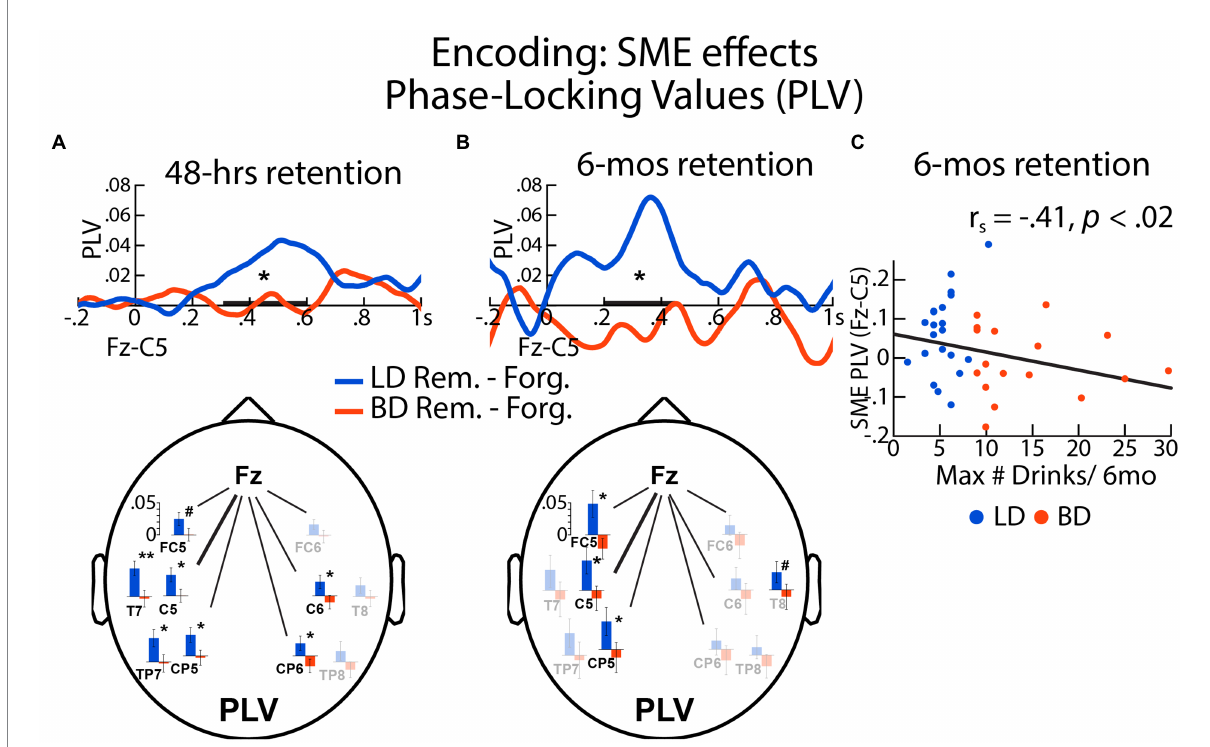
FIGURE 4 The SMEs on phase locking values (PLVs) during encoding were expressed as differences in PLVs between later remembered and later forgotten items assessed after (A) 48 h and (B) 6 mos for BD and LD groups. Here shown are the PLVs for the Fz-C5 electrode pair. (C) SME-evoked Fz-C5 synchrony during encoding associated with 6-mos recognition was negatively correlated with the self-reported maximum number of drinks consumed on a single occasion during the previous 6 mos. The electrode maps show the SME effects on the theta-entrained synchrony between Fz and other electrodes associated with a 48-h and a 6-mos interval, respectively. Fully colored bar graphs show the electrode pairs with significant LD – BD group differences. No group differences are marked with faint-colored bar graphs. * p < = 0.05; # p < = 0.10; bolded bar on the x-axis represents the time window of